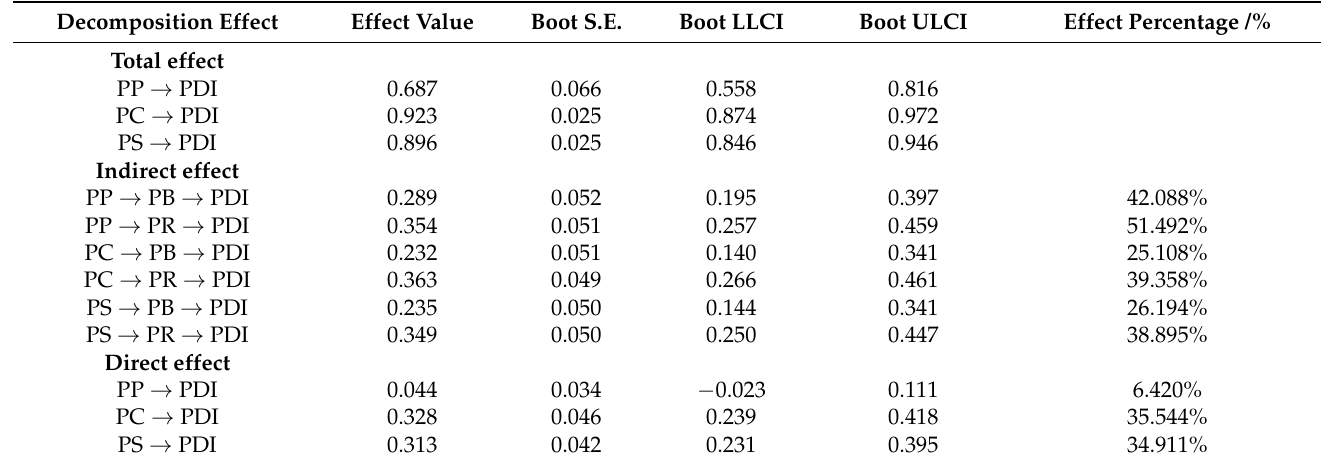
Table 7. The test results of decomposition